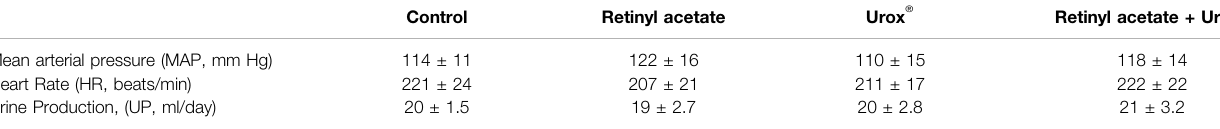
TABLE 3 | The effects of the UROX ® on retinyl acetate (RA) – induced changes in cardiovascular parameters and diuresis.